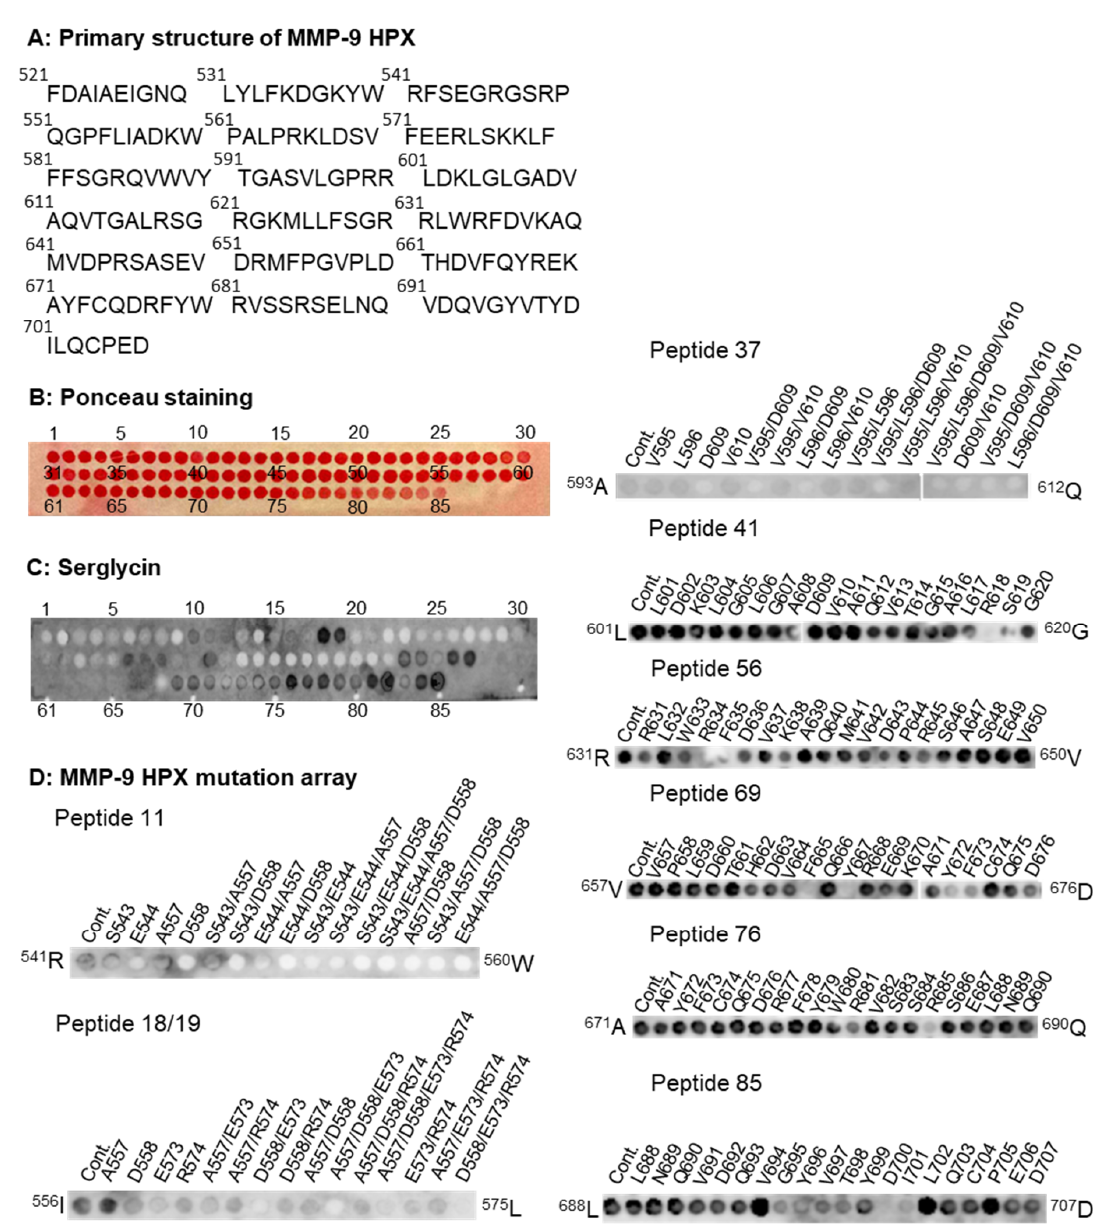
Figure 7. Binding of SG to MMP-9 HPX peptide arrays. ( A ) Primary structure of the HPX domain. ( B ) Ponceau staining of the 20-mer peptides bound on a cellulose membrane, where each peptide was obtained from a peptide walk along the entire MMP-9 HPX sequence with an interval of two amino acids. For simplicity, every fifth peptide in the array is numbered. ( C ) Binding of recombinant Ht-SG to peptides in the HPX domain. ( D ) Binding of recombinant Ht-SG to HPX peptide arrays containing mutated amino acids based on the binding obtained in Figure 7C. Two different arrays were performed where either (1) a combination of the predicted four possible amino acids from the binding pattern obtained in Figure 7C were mutated or (2) where every amino acid in the peptide was mutated as described in the Materials and Methods. Shown above each array is: (1) the number of the peptide in Figure 7C that is used for the mutation screen and (2) the name and number of the parent amino acid mutated. Shown also is the position of N- and the C-terminal amino acid of the 20-mer peptides. The un-mutated control peptide is labelled with Cont.